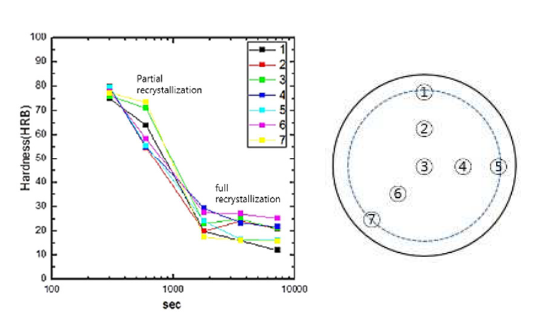
Fig. 5. Hardness result of 1h heat treated OFHC copper after ECAP process.